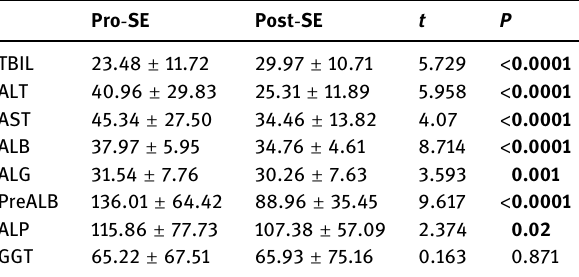
Table 2: Comparison of liver function before and after splenic embolization Pro - SE